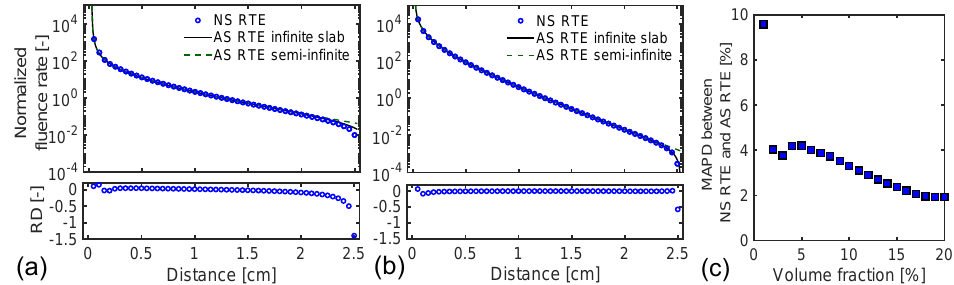
Figure 7. ( a , b ) Fluence rates calculated from the RTE at different positions for the volume fractions of ( a ) 1% ( g = 0.046) and ( b ) 20% ( g = 0.003). The AS of the RTE (Equation (6)) for the infinite slab and semi–infinite medium are compared. ( c ) MAPD, D Φ ( N , R ; A , R ) , between NS and AS for the RTE at different volume fractions. The other details are the same as Figure